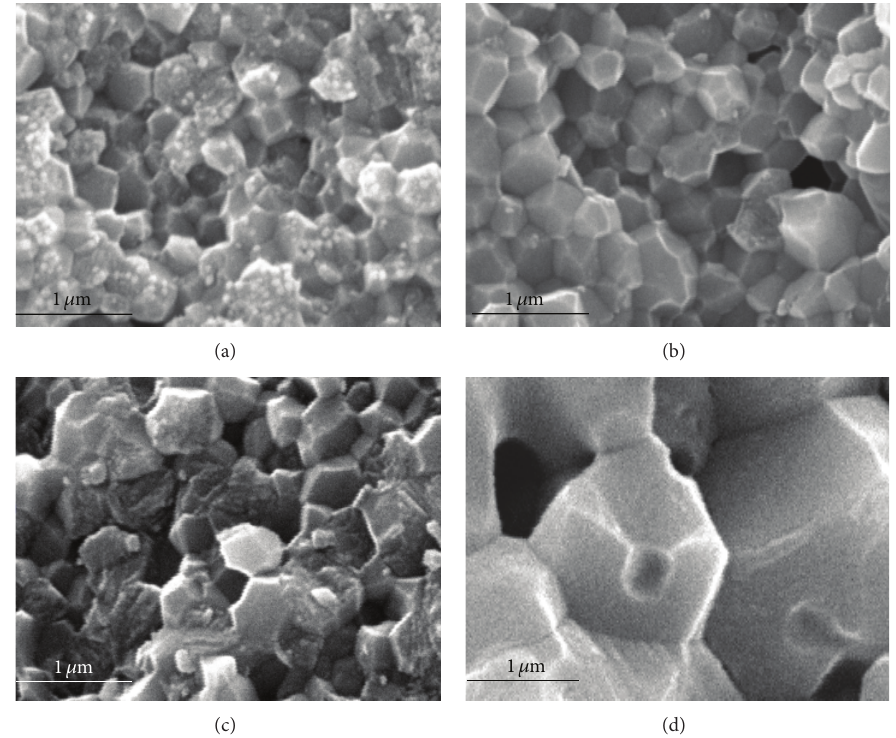
Figure 5: SEM images of the fractured surfaces of the uncoated samples. (a) 30–50 nm, (b) 50–100 nm, (c) 100–300 nm, and (d) 300–500 nm.